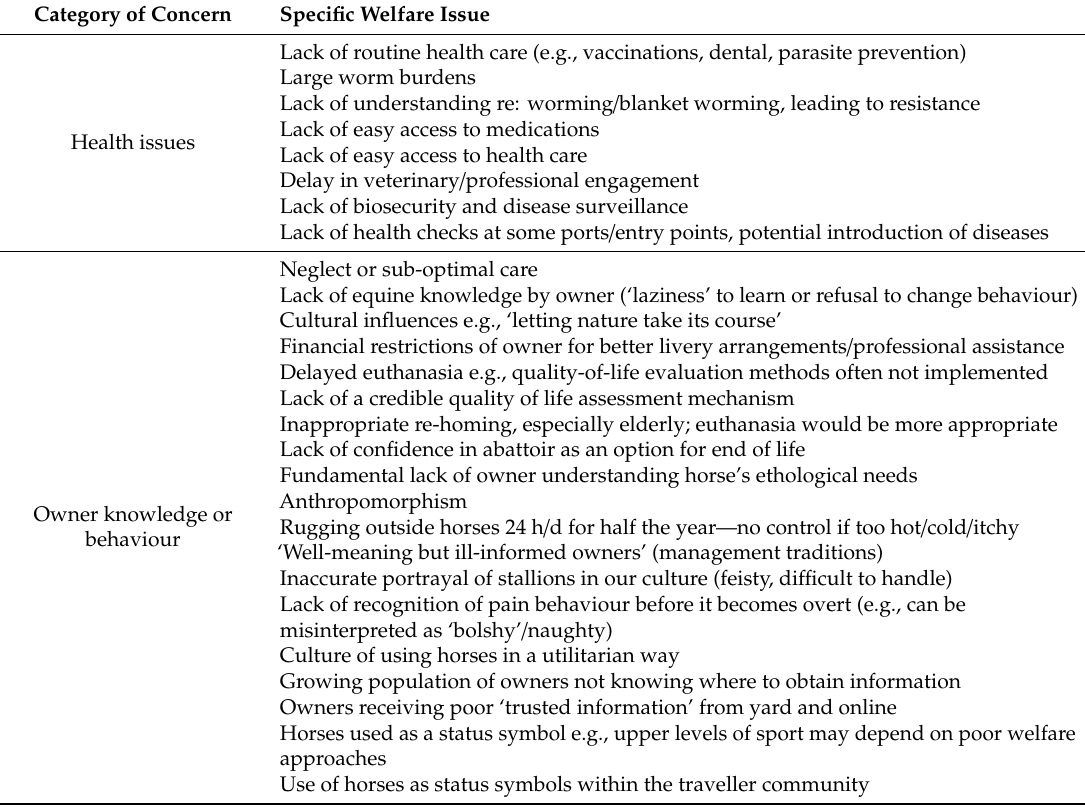
Table 1. Welfare issues for horses (unranked) derived from thematic analysis of the anonymous online discussion boards, sorted for